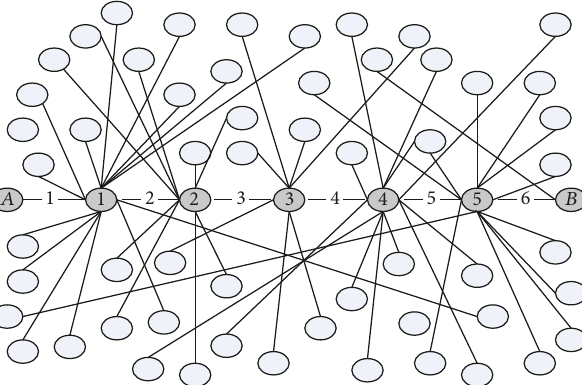
Figure 1: The six-degree theory of partition theory.